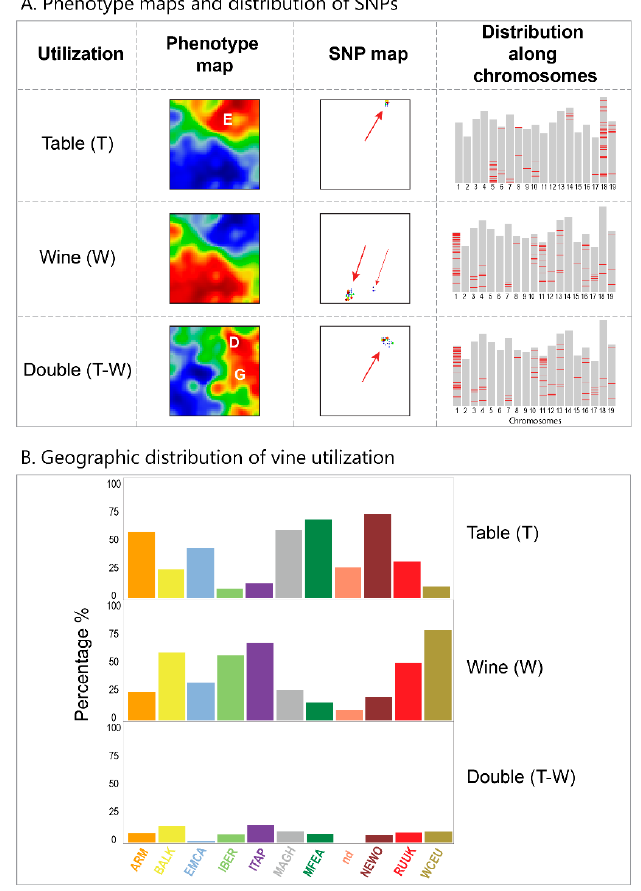
Figure 3. Association with vine utilization: ( A ) Phenotype maps color code correlation between SNP-scores and cultivar-utilization (table, wine, double) between red (high correlation) and blue (low correlation). Top 100 correlated SNPs accumulate in narrow regions of the SNP map (see arrows) in and around spots E (table utilization), H (wine) and D (double) and on selected chromosomes (assembly version 12X.V2). ( B ) Distribution of vine utilization (percentage of the respective vine cultivars) indicates enrichment of table utilization (T) in Eastern cultivars, of wine utilization (W) in western ones (WCEU, ITAP, IBER, BALK), while the distribution of double usage cultivars partly resembles that of wine vines however with increased frequencies in MFEA and MAGH.